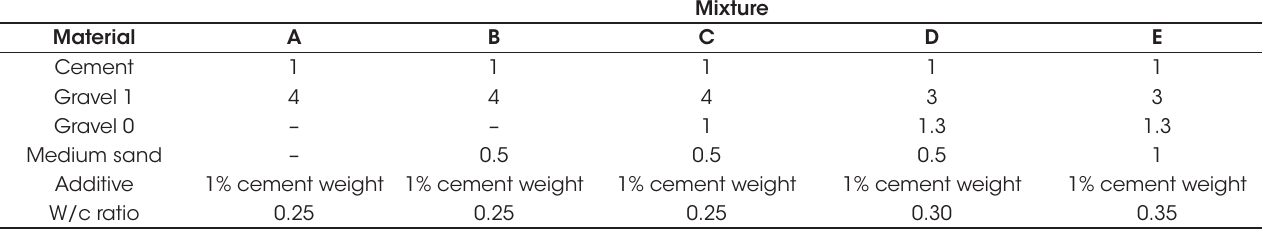
Summary of the mixtures